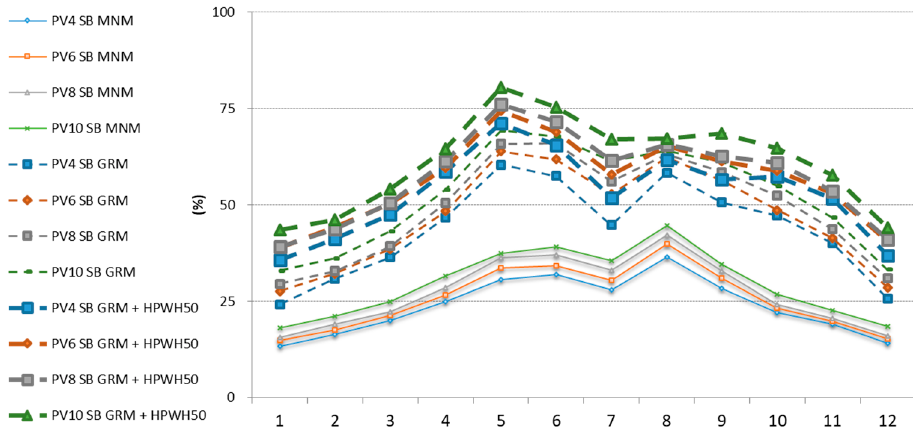
Figure 19. Monthly self-sufficiency rate (SSR) of PV and SB and HPWH for SB (M).